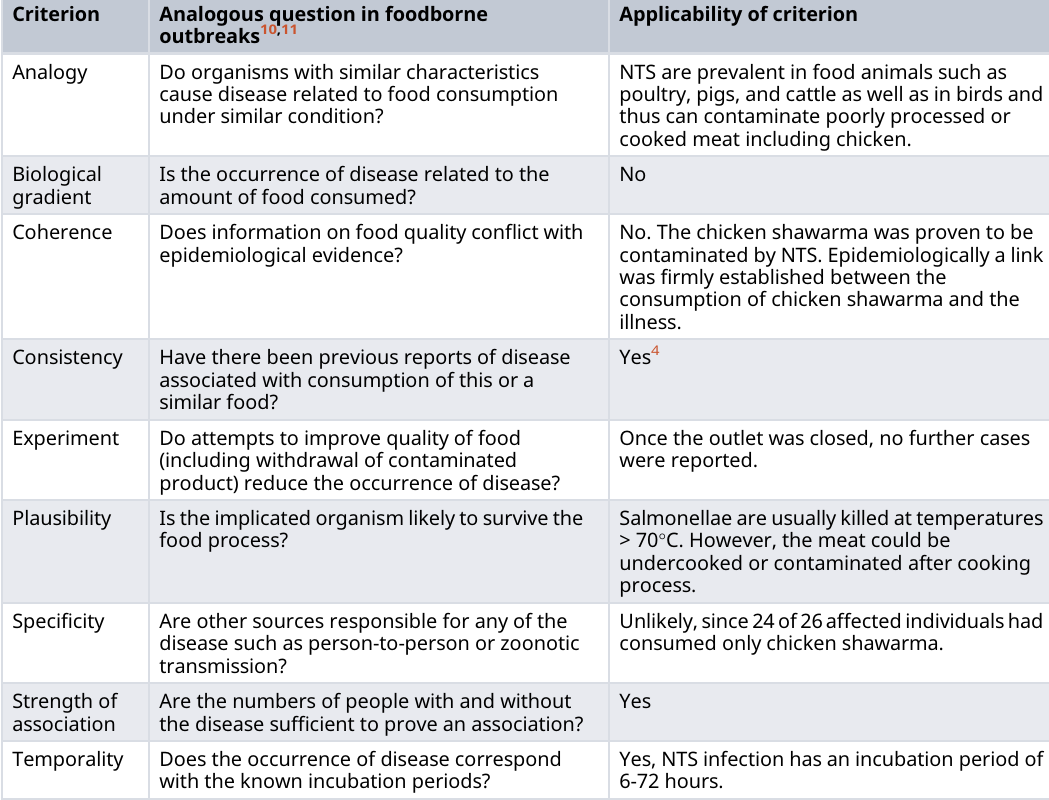
Table 2. Causality assessment using the Bradford Hill ’ s criteria.